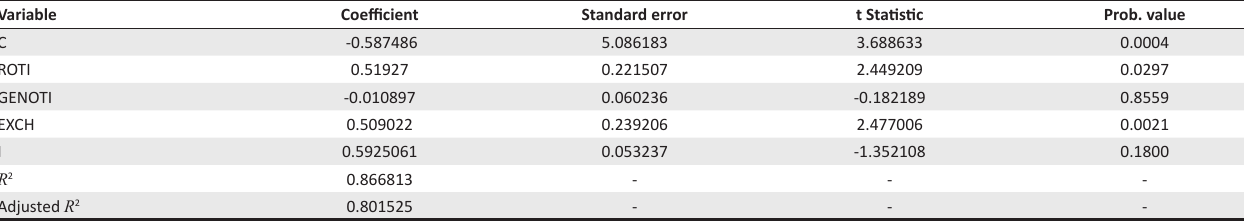
TABLE 4: Vector error correction model